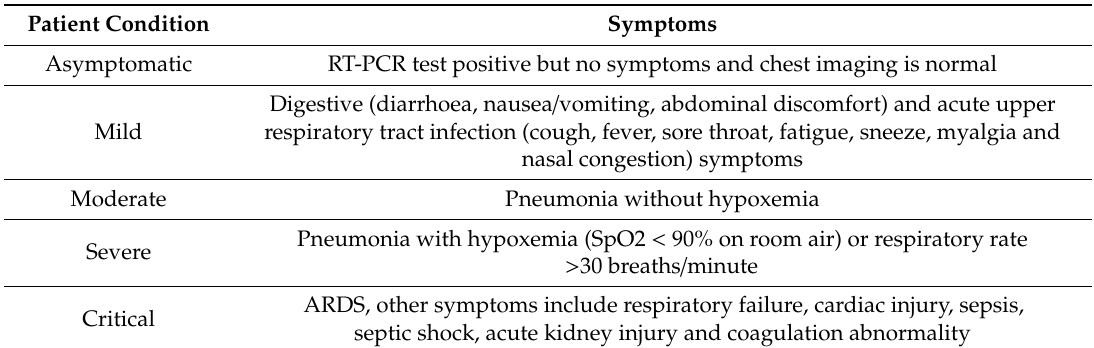
Table 1. Symptoms of SARS-CoV-2